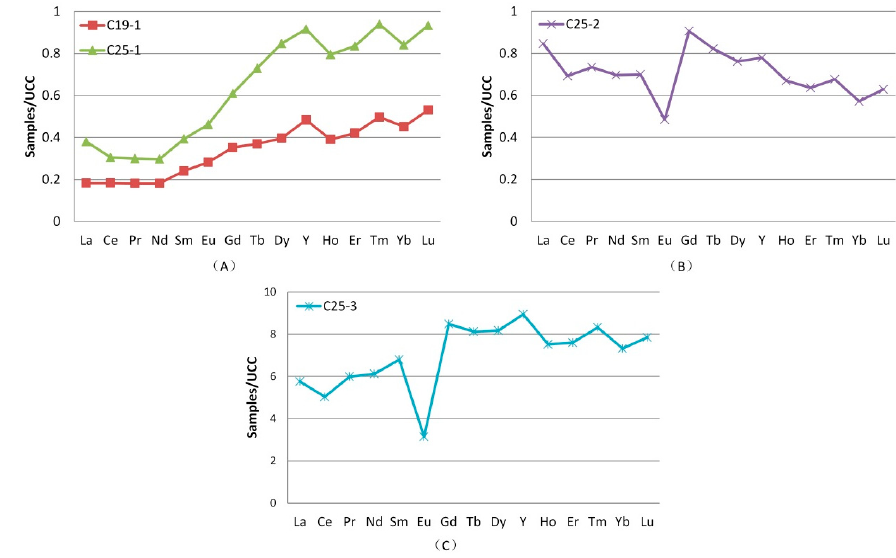
Figure 14. Distribution patterns of REE in the coal samples from the Shiping mine. REE are normalized by Upper Continental Crust (UCC) [32]. ( A ) Distribution patterns of REE in sample C19-1 and C25-1; ( B ) Distribution patterns of REE in sample C25-2; ( C ) Distribution patterns of REE in sample C25-3.